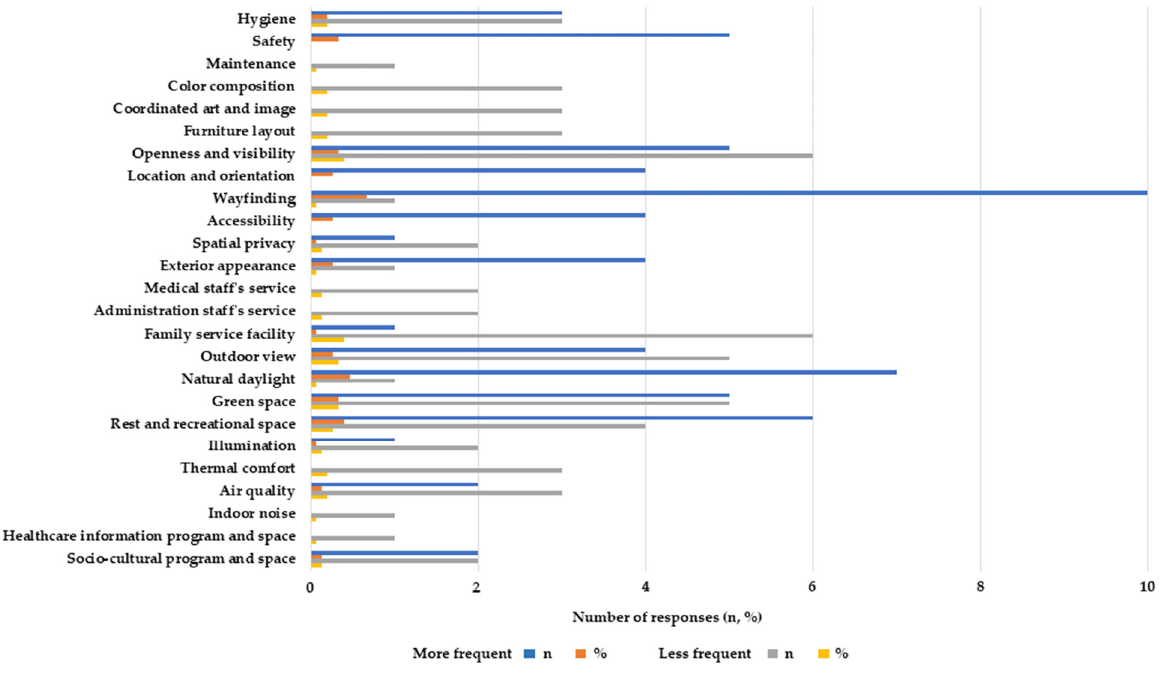
Figure 2. Frequency of applied variables in design implementation for therapeutic healthcare envi- ronments (Appendix A: Table